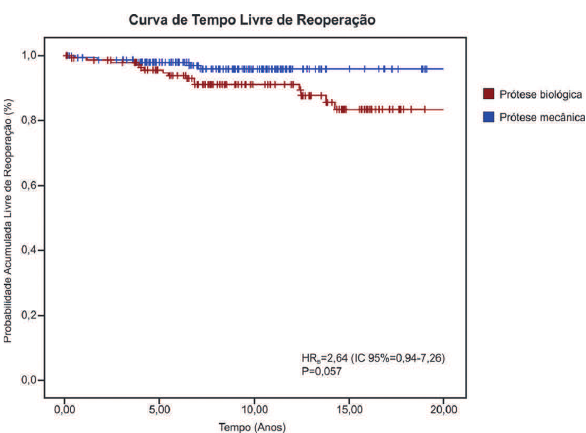
Fig. 2 - Curva de Kaplan-Meier para avaliar tempo livre de